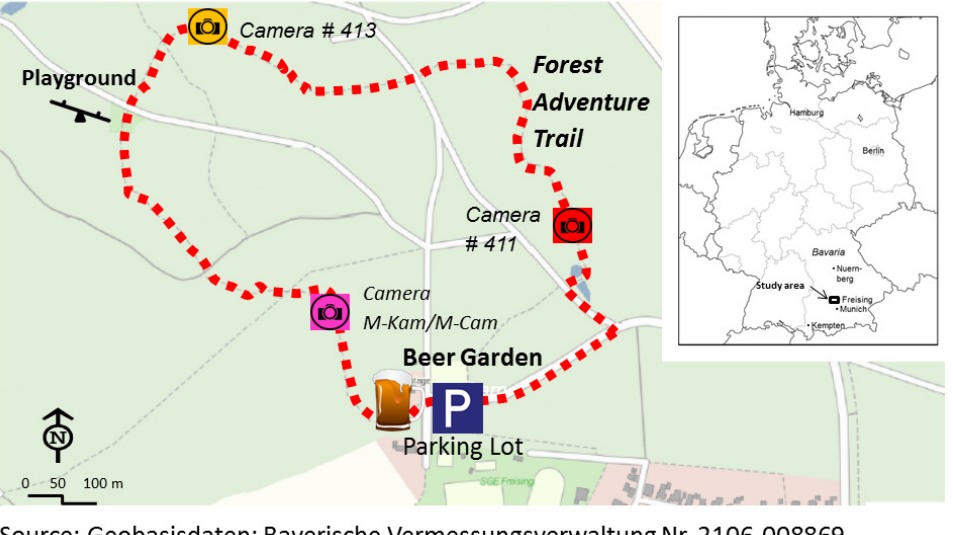
Figure 1. Map of the Forest Adventure Trail and monitoring sites north of Freising, Bavaria, Germany, with color codes for the cameras. For camera types related to the color codes, visitor monitoring questions, and data assessment procedures, see Appendix A, Table A1.